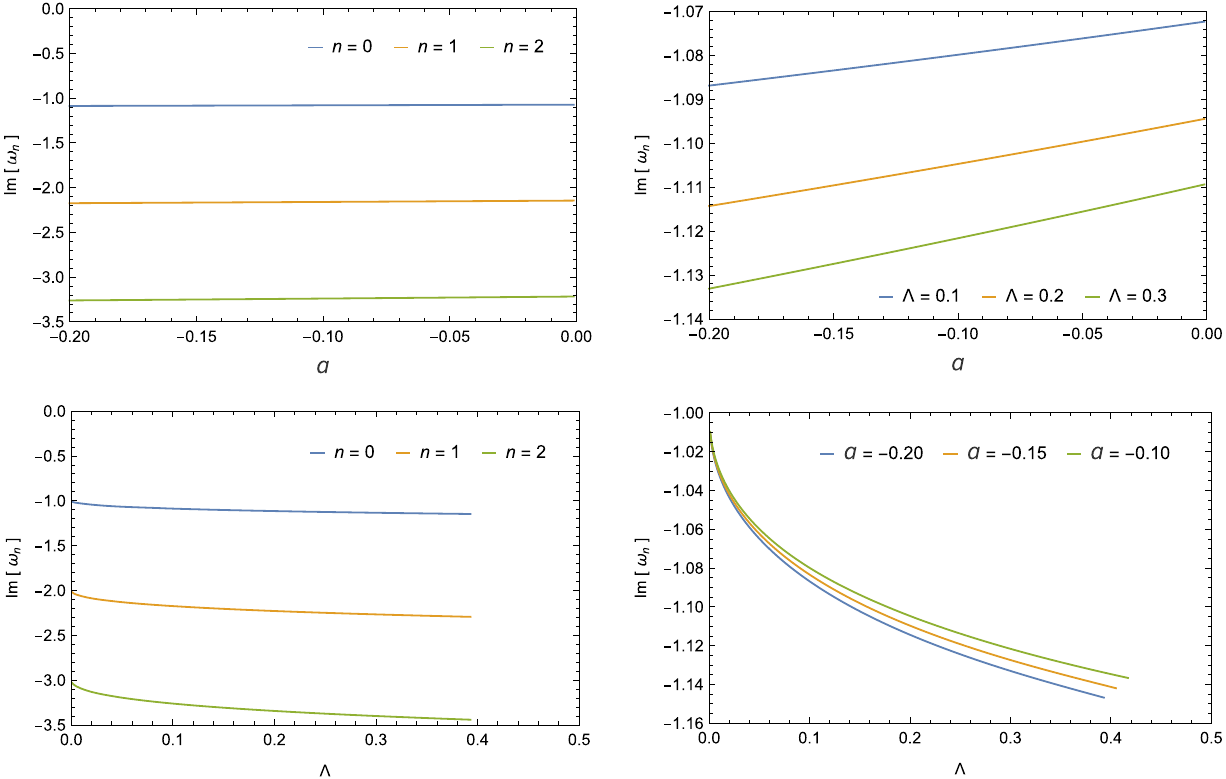
Fig. 2 (dS) Case 1: a < 0. Top panel: massless scalar QBSs as a function of the GB coupling constant for (cid:2) = 0 . 1 (left) and n = 0 (right); M = 1 / 2. Bottom panel: massless scalar QBSs as a function of the cosmological constant for a = − 0 . 20 (left) and n = 0 (right); M = 1 /